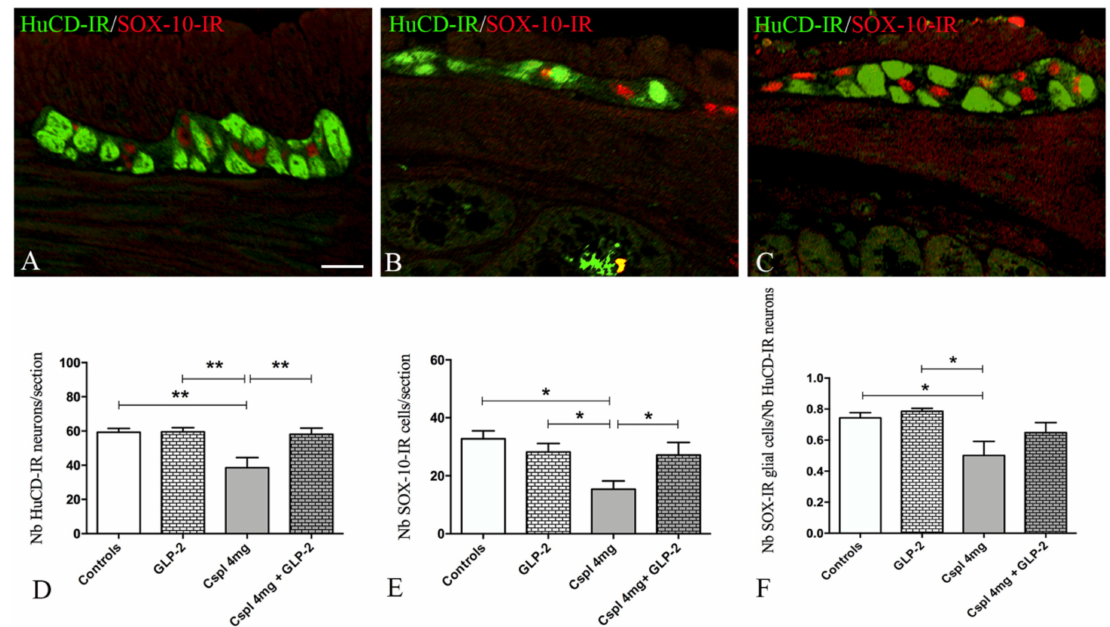
Figure 5. HuCD (green) and SOX-10 (red) double-labeling in the myenteric ganglia ( A – C ). Controls ( A ), cisplatin ( B ) and cisplatin + [Gly2]GLP-2 ( C ) group. HuCD-IR neurons appeared larger and more numerous in controls and in co-treated mice ( A , C ) compared to those in cisplatin-treated mice ( B ). SOX-10-IR enteric glial cells (EGCs) are in close apposition to the labeled neurons in control and co-treated mice ( A , C ) but dispersed and less numerous in cisplatin-treated mice ( B ). Scale bar = 50 µ m. Quantitation of the total neuron and EGCs number ( D , E ); EGCs / neurons ratio ( F ). Measurements were performed considering the well-oriented ganglia. Data are expressed as mean ± SEM. One-way ANOVA test, Post hoc Newman Keuls’. ** ( p < 0.01), * ( p < 0.05). n = 4–6 for each